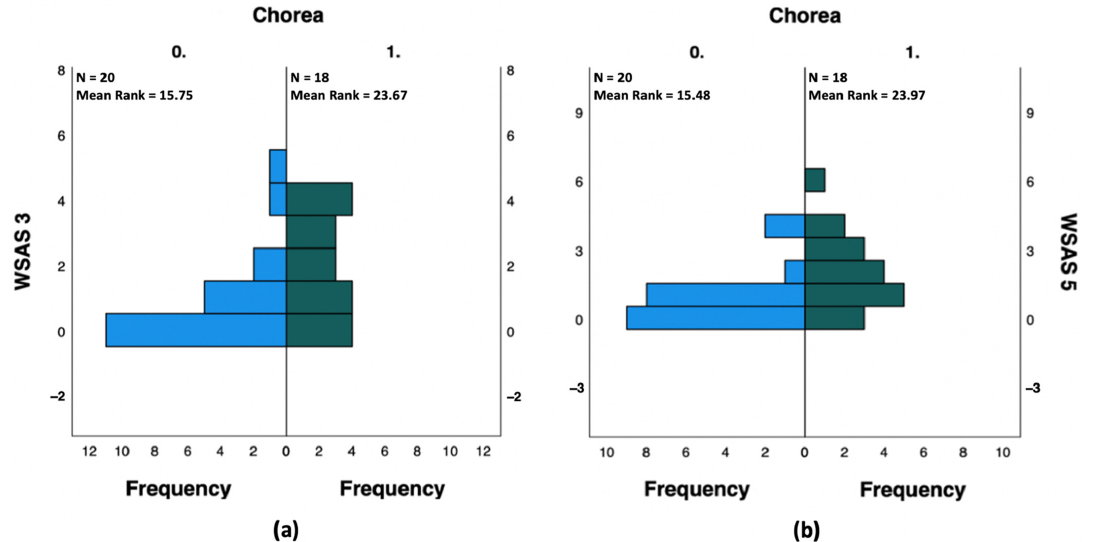
Figure 2. Independent-Samples Mann-Whitney U Tests reporting that ( a ) WSAS question 3 (private leisure) and ( b ) WSAS question 5 (close relationships) scores were significantly higher in SC patients (Chorea 1) were higher than those of nSC patients (Chorea 0).